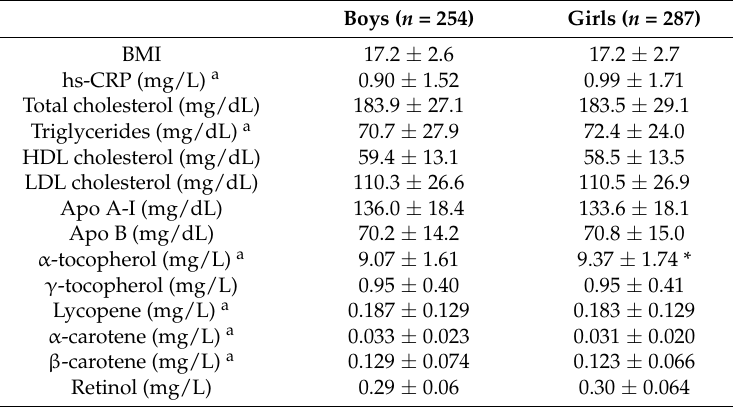
Table 1. Body mass index (BMI) and plasma biochemical variables (mean ± SD) in prepubertal children by